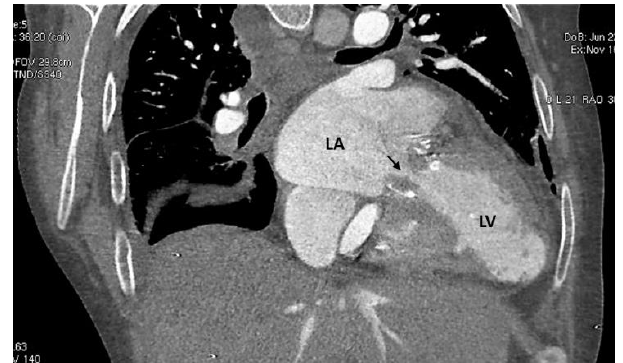
Figure 3. CCT showing obstruction to the blood flow across the stenotic mitral valve prosthesis (arrow). LA: left atrium; LV: left ventricle.